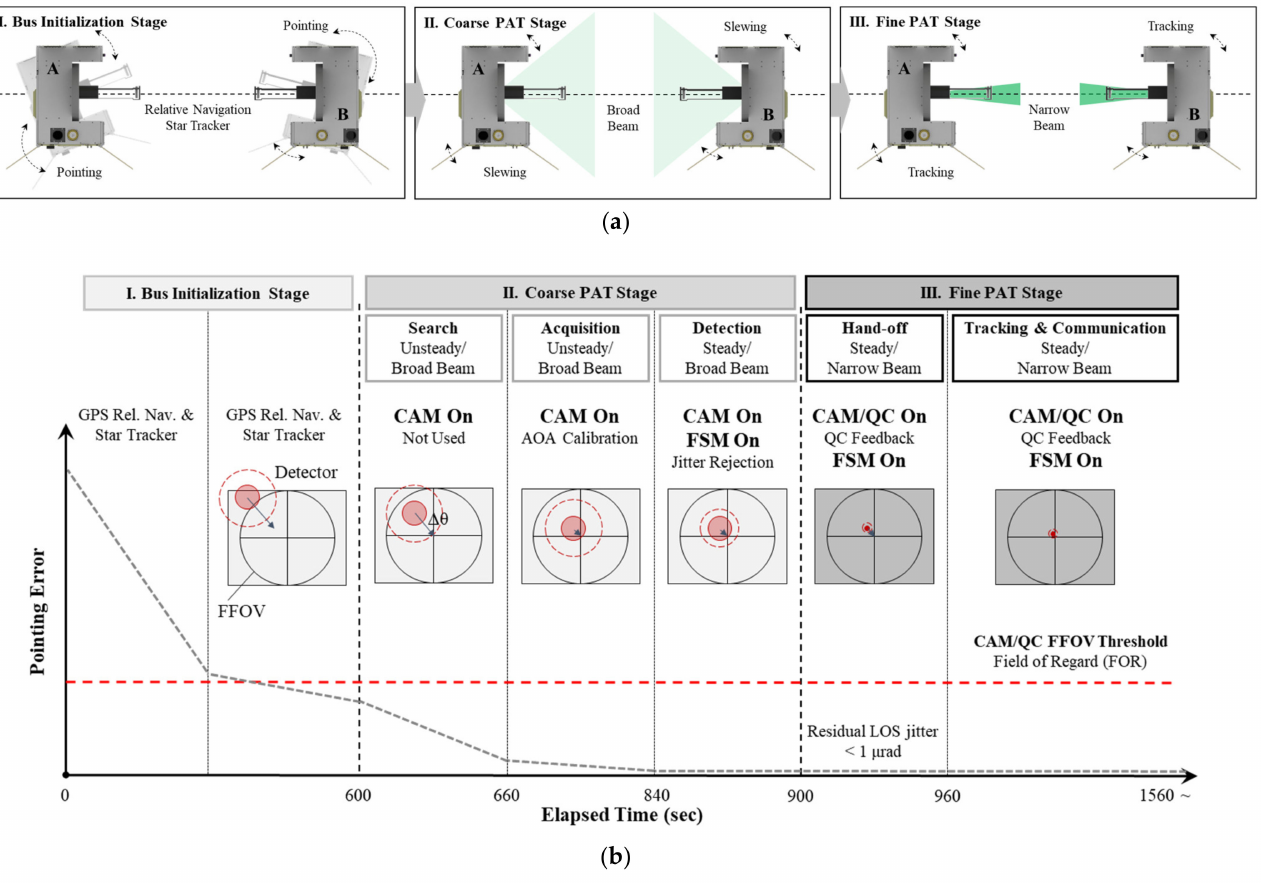
Figure 5. Pointing, acquisition, and tracking (PAT) sequence for laser crosslink: ( a ) nanosatellite orientations and operations, depicting the beam divergence angle; ( b ) beam spot on tracking sensor and pointing error profiles over substages. After the Acquisition substage is ended, the FSM is available to reject